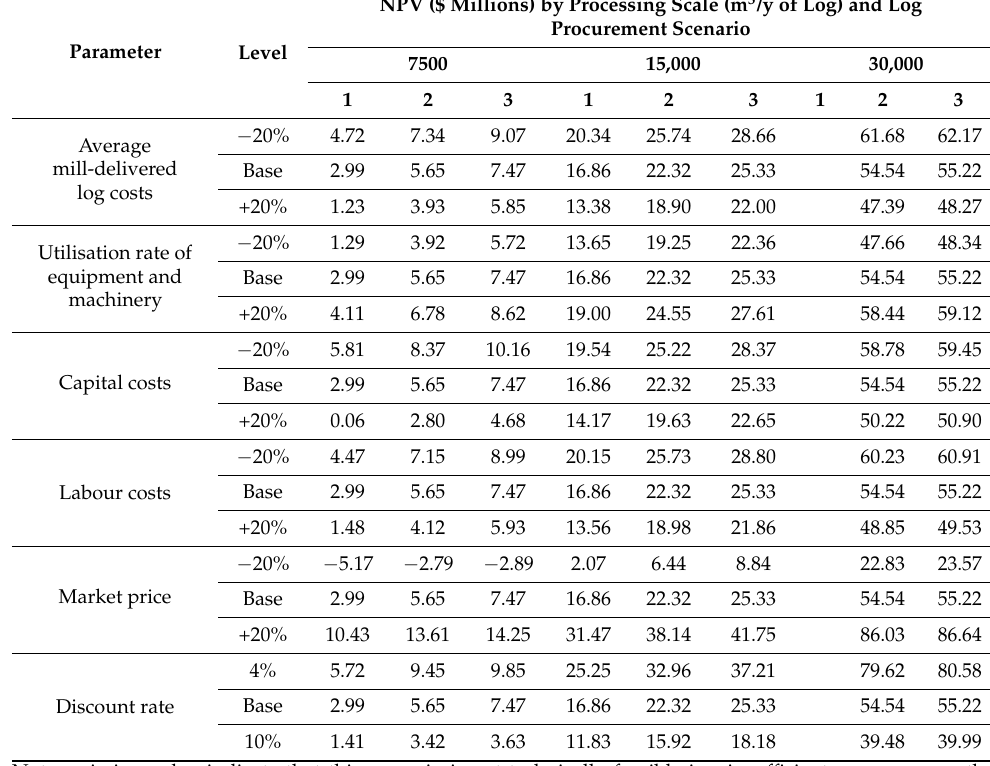
Table A4. Sensitivity of NPV of two-stage LVL manufacture to changes in levels of several important model parameters at facility location